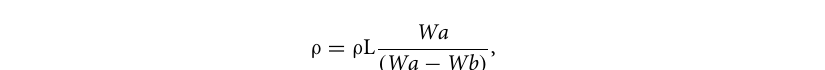
Figure 2. SEM images for ( a ) micro Bi, ( b ) nano Bi, ( c ) PLA with micro Bi, ( d ) PLA with nano